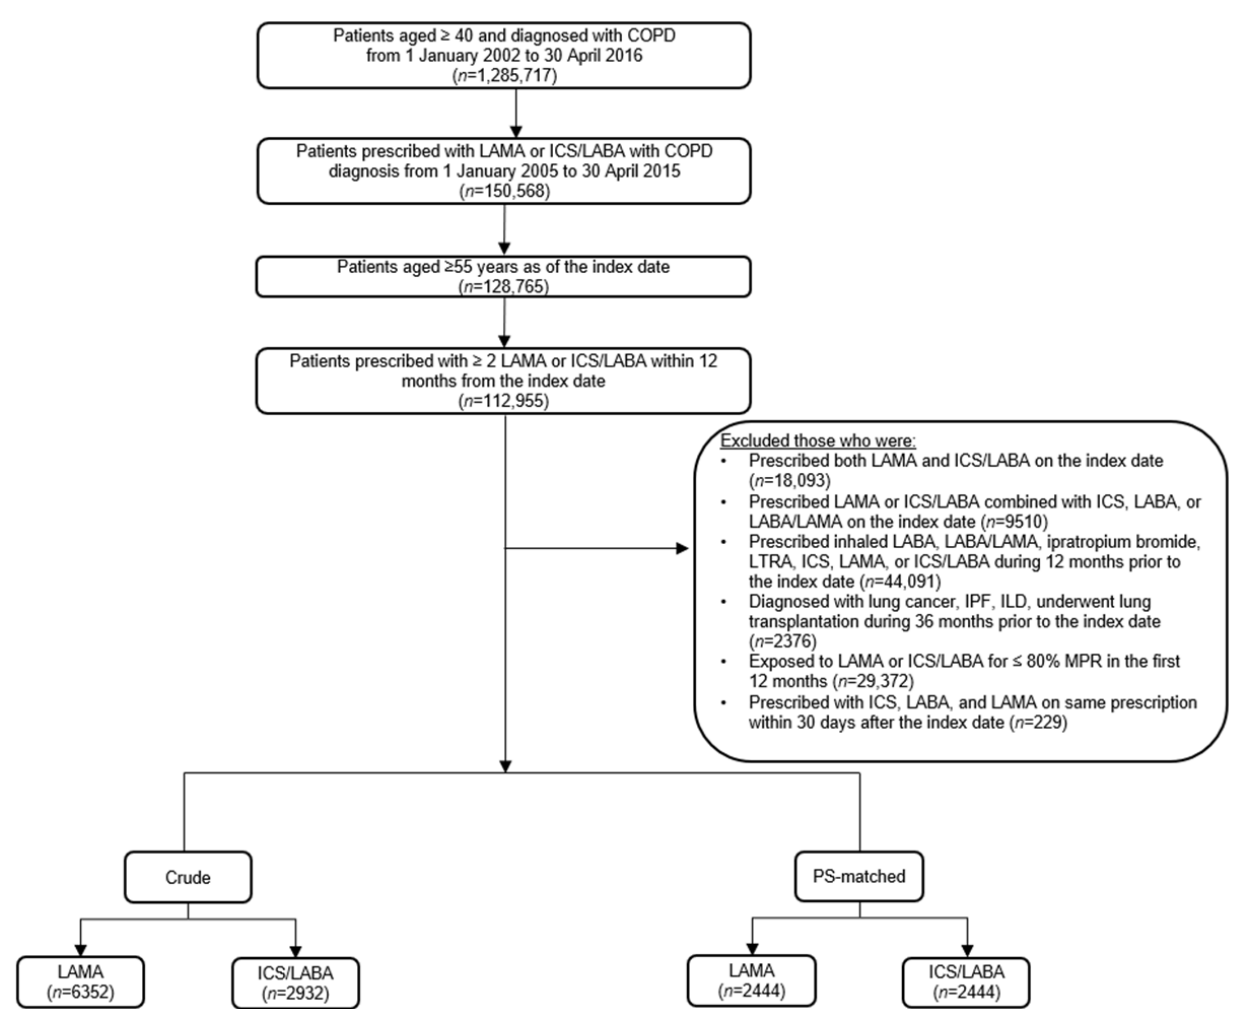
Figure 1. Flowchart of the study population. LAMA, long-acting muscarinic antagonist; ICS/LABA, inhaled corticosteroid plus long-acting beta-2 agonist; COPD, chronic obstructive pulmonary disease; MPR, medical possession rate; LTRA, leukotriene receptor antagonist; ILD, interstitial lung disease.